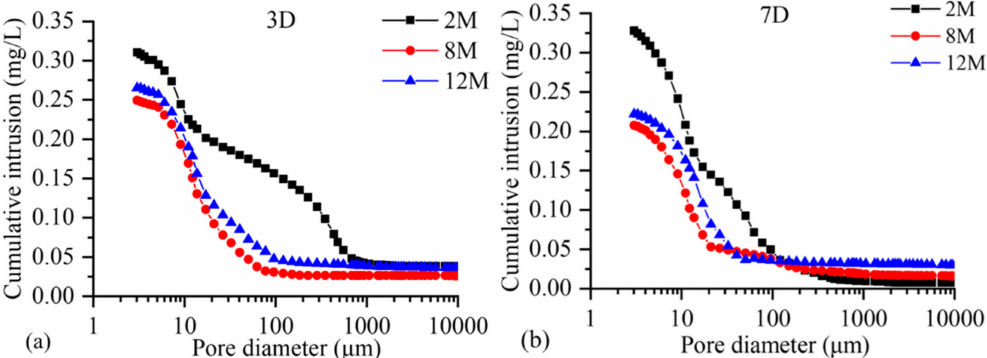
Figure 3. Cumulative pore volumes of alkali-activated BFFS paste at different ages: ( a ) 3 d; ( b ) 7